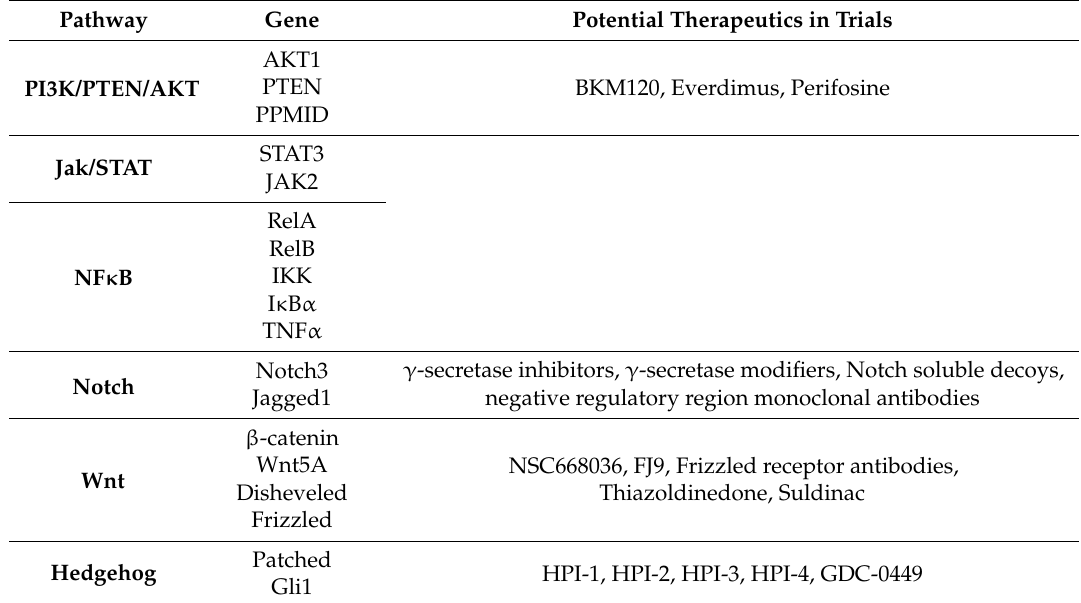
Table 2. Summary of targetable